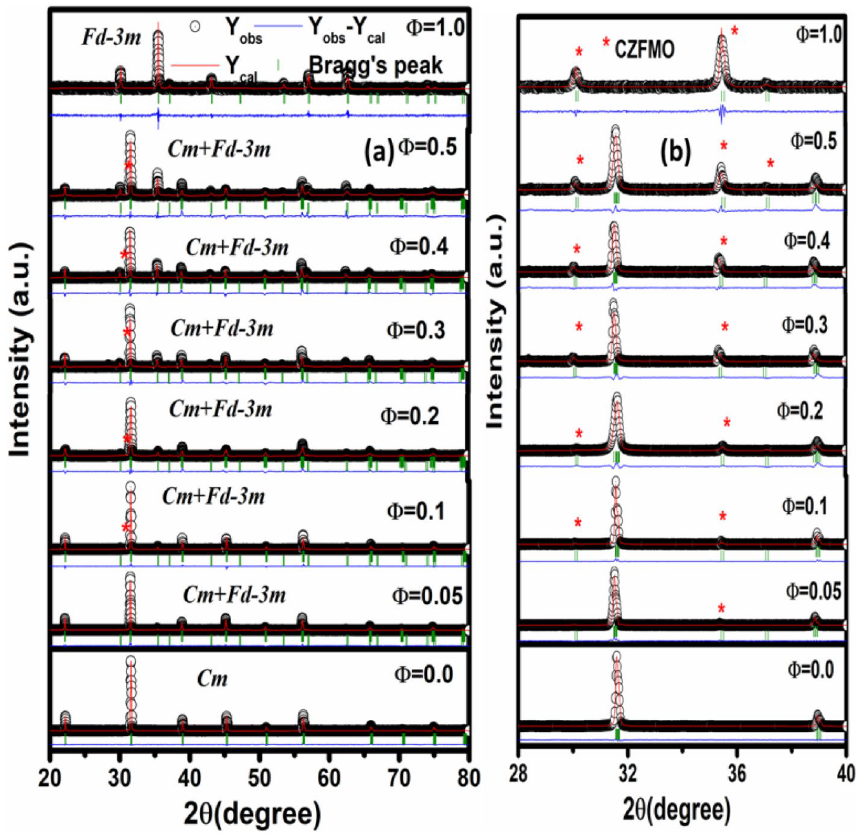
Figure 1. ( a ) The Rietveld refinement result of XRD patterns of (1 − Φ) PbFe 0.5 Nb 0.5 O 3 -ΦCo 0.6 Zn 0.4 Fe 1.7 Mn 0.3 O 4 ((1 − Φ) PFN-Φ CZFMO) (Φ = 0.0, 0.05, 0.1, 0.2, 0.3, 0.4, 0.5, 1.0) composites at RT. ( b ) Enlarged view of the XRD patterns in the 2θ range 28°–40° to show the formation of composite with the appearance of reflection for both the constituent